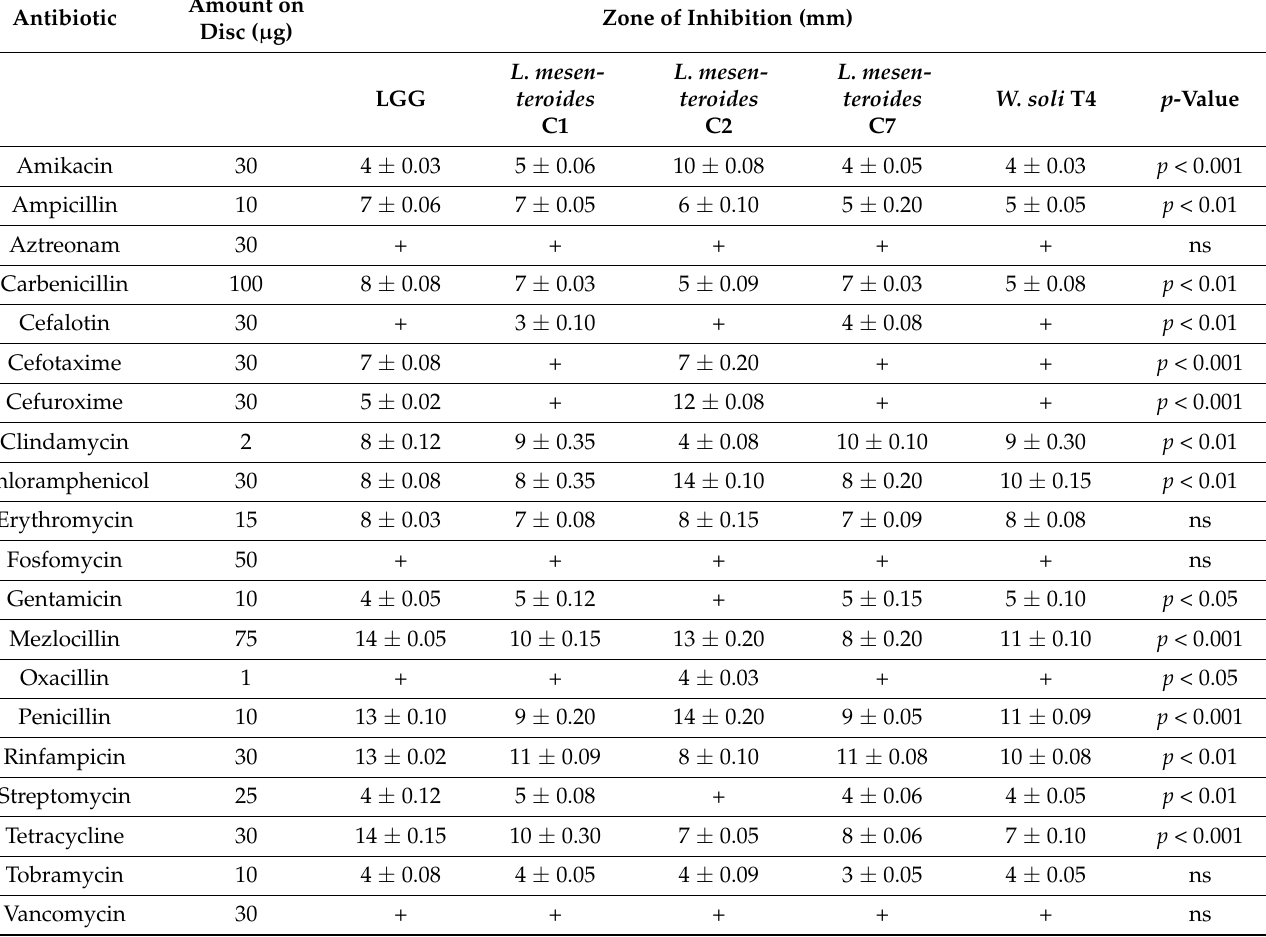
Table 2. Resistance to antibiotics of different isolates. The zones of inhibition were measured from the center of the disc and recorded in mm ± SD. Absence of inhibition halo was indicated as (+), ns: not significant. Amount on Antibiotic Disc ( µ g)